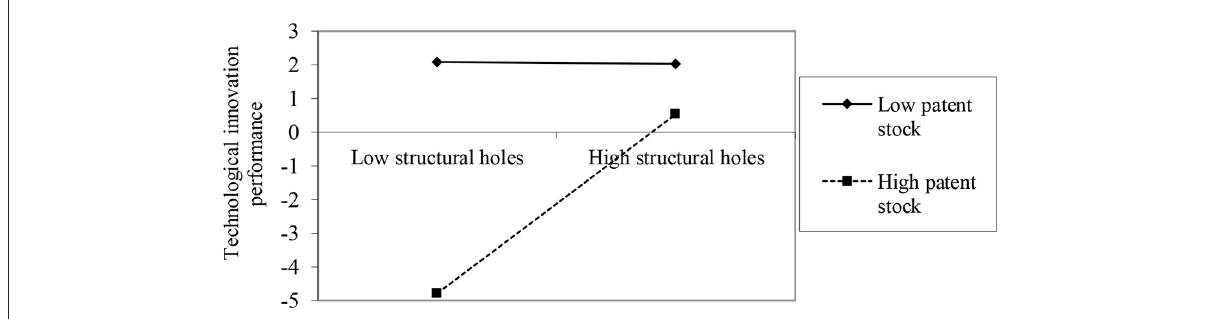
FIGURE4 The moderating effects of patent